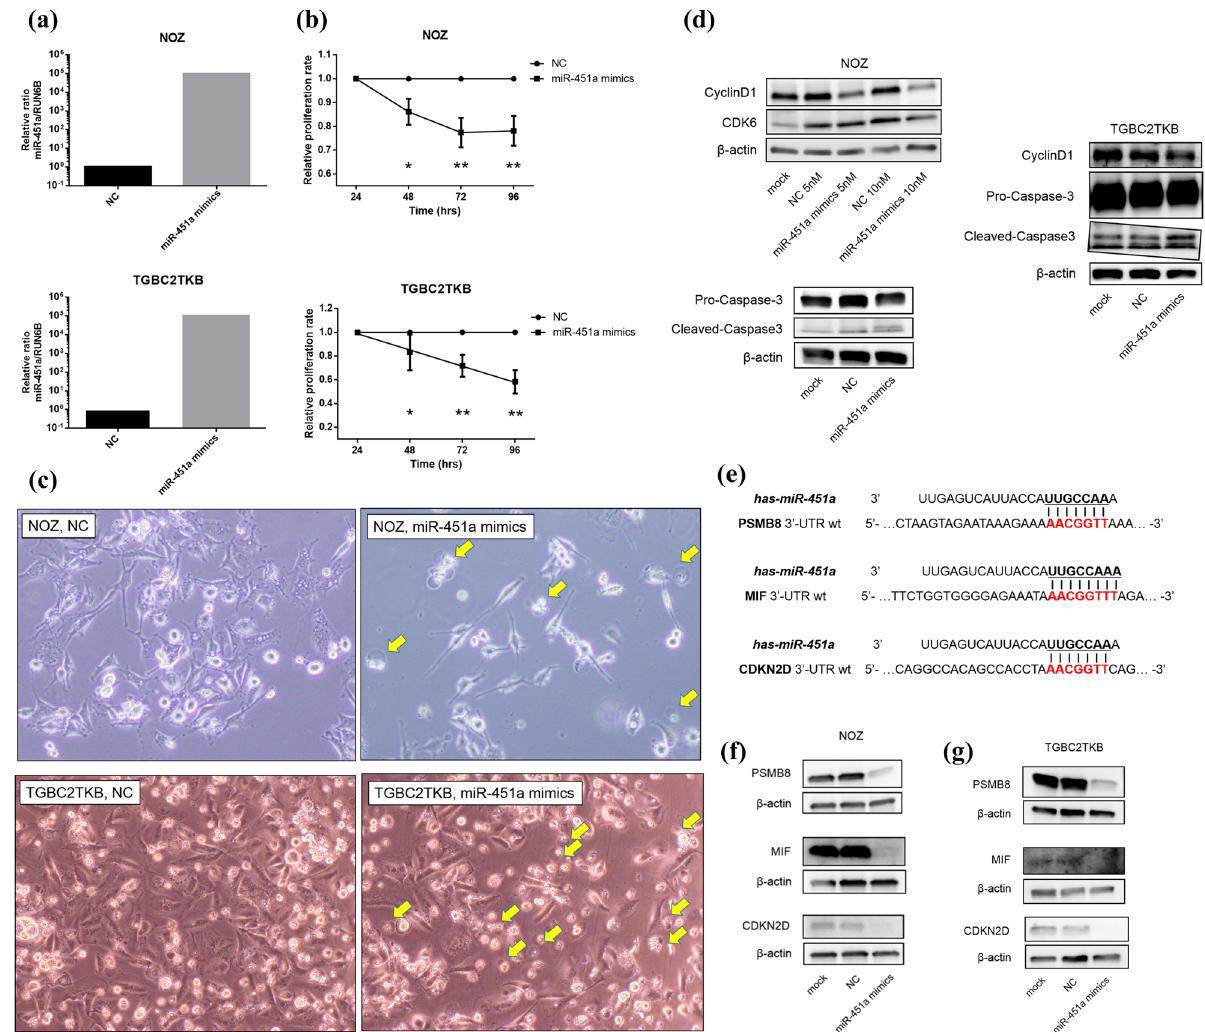
Figure 5. MiR-451a inhibits cell proliferation and induces apoptosis in gallbladder cancer cell lines. ( a ) Validation of the miR-451a expression level after the transfection of miR-451a mimics and negative control in NOZ cells and TGBC2TKB cells was measured by RT-qPCR. The miRNA expression levels were normalized to the RNU6B expression. ( b ) The proliferation rate in both NOZ cells and TGBC2TKB cells after the transfection of 10 nM miR-451a mimics or negative control was assessed by an MTT assay. Both cells showed significantly decreased cell proliferation after the transfection of miR-451a mimics. ( c ) Under a phase-contrast microscope, floating, round and chromatin-concentrated cells were observed after the transfection of 10 nM miR-451a mimics, suggesting that apoptosis could be induced by the miR-451a mimics in GBC cells. ( d ) Western blotting showed that cyclinD1 and CDK6 were reduced in both NOZ cells and TGBC2TKB cells after the transfection of miR-451a mimics, depending on the concentration of miR-451a mimics. In addition, increased